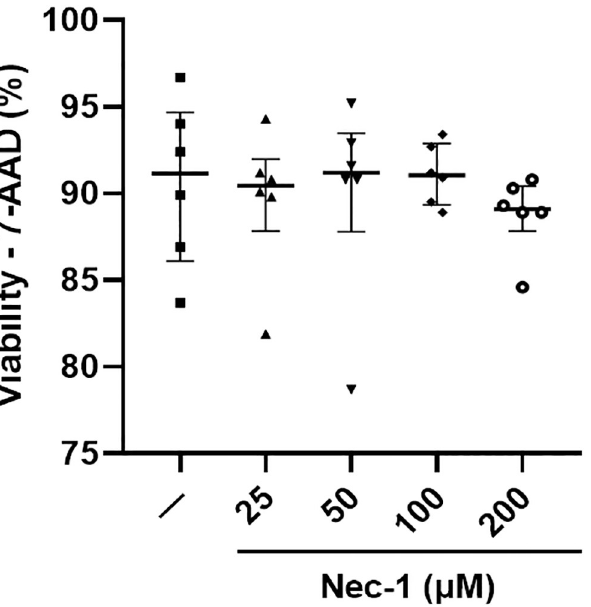
Fig 3. Viability of dissociated islet cells after 7 days of tissue culture in control media (—) or media supplemented with 4 different doses of necrostatin-1 (25, 50, 100, or 200 μ M of Nec-1) on day 3. 3000 islet equivalents were dissociated into single cells using Accutase, stained with 7-amino-actinomycin D (7-AAD) viability dye for 30 minutes at 4˚C, and analyzed by flow cytometry to quantify dead cells. n = 6 for each group. Data are expressed as median and interquartile range.